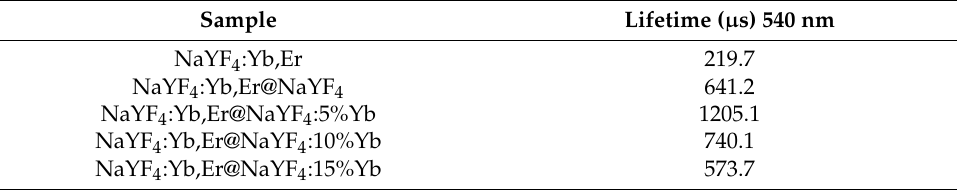
Table 1. Calculated lifetimes of Er 3+ .